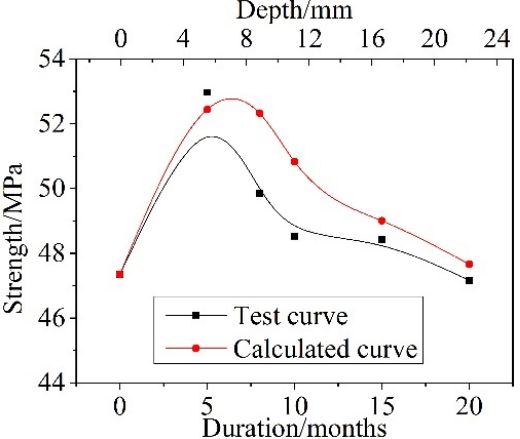
Figure 10. Comparison between the test values and calculated values of compressive strength after different dry and wet cycle inspection periods.